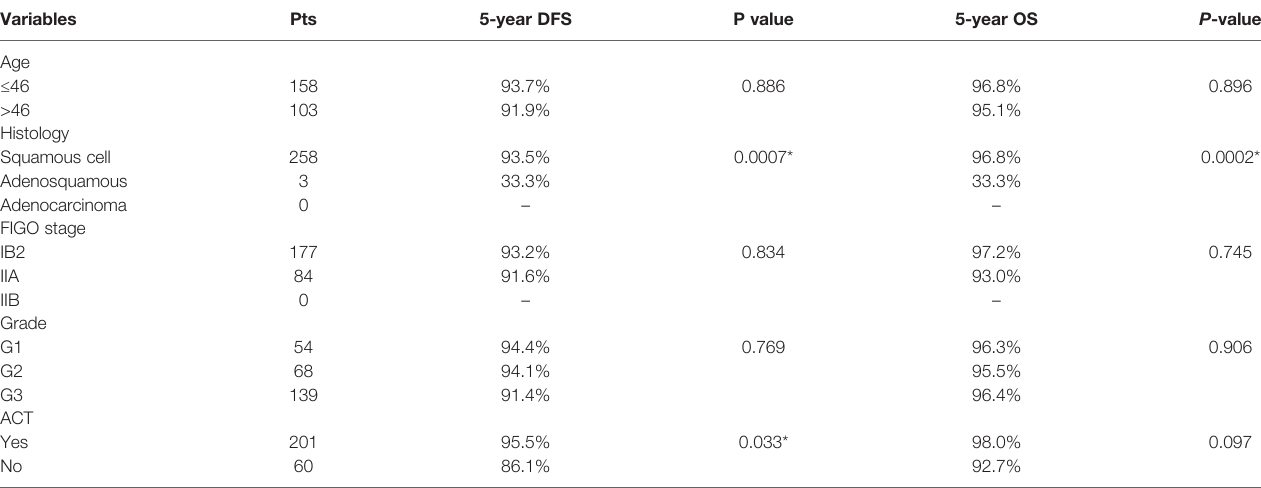
TABLE 2 | Multivariate analysis of variables predictive of the DFS and OS in optimal responders. Variables